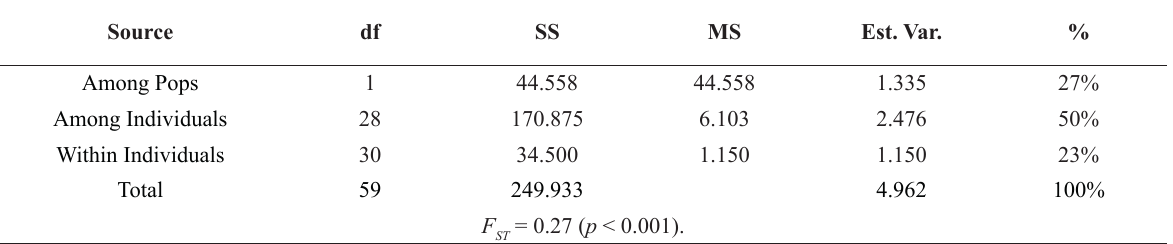
Summary of the analysis of molecular variance (AMOVA) for all populations, based on 12 microsatellite